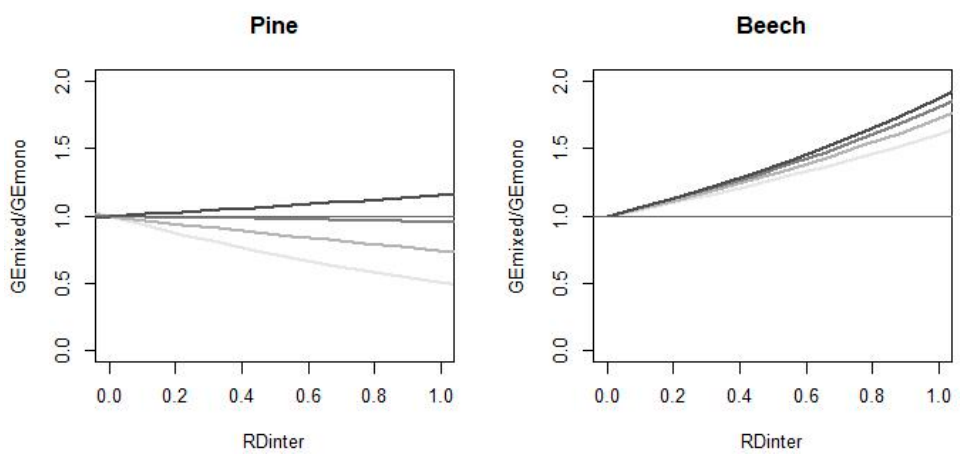
Figure 3. Influence of humidity, defined by the Martonne aridity index M (mm/°C), on the growth efficiency ratios between mixed and monospecific stands (GEmixed/GEmono), reflecting the variation in the inter ‐ specific competition effect on pine and beech.